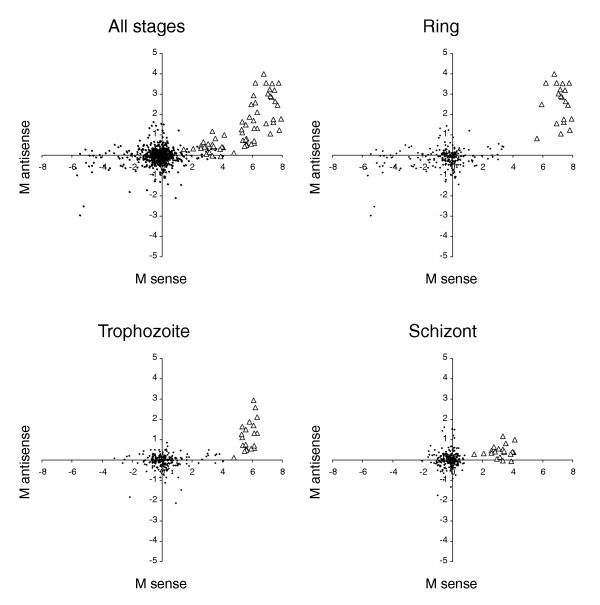
No inverse correlation between sense and antisense ratio changes. Scatter plots of log2 ratio of expression (M) (CSA-panned parasites over CD36-panned) for antisense oligonucleotides against sense oligonucleotides for var genes. Data are shown for ring, trophozoites and schizont stages from biological replicate 1. Oligonucleotides corresponding to var2csa are represented by open triangles and the other var genes from the FCR3 strain are displayed as black dots. Oligonucleotides with the highest log2 ratio of expression in CSA- compared with CD36-panned parasites often correspond to those with the highest corresponding ratios for antisense abundance (upper right datapoints). Similarly, several sense transcripts apparently highly upregulated in CD36 correspond to upregulated antisense oligos at the same loci (lower left datapoints). These data are not consistent with a direct transcriptional silencing role for antisense transcription.